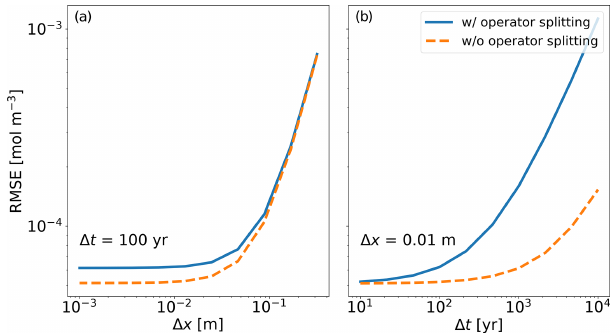
Figure 4. Convergence of the Van Genuchten (1981) test. (a) RMSE as a function of grid spacing. (b) RMSE as a function of time step